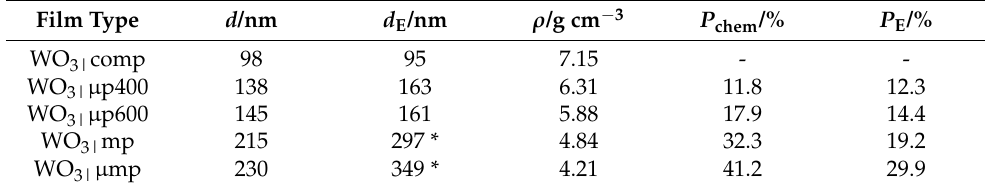
Table 5. Average thickness d obtained from profilometry and d E obtained from ellipsometry, density ρ and values of the porosity P chem and P E obtained from wet chemical analysis and ellipsometry,